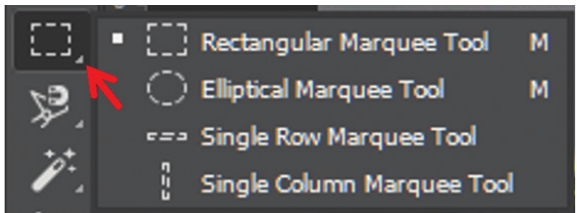
Figure 2. Closed selection tool group expanded to show all hidden tools. Hidden tools can be shown by right-clicking the indicated